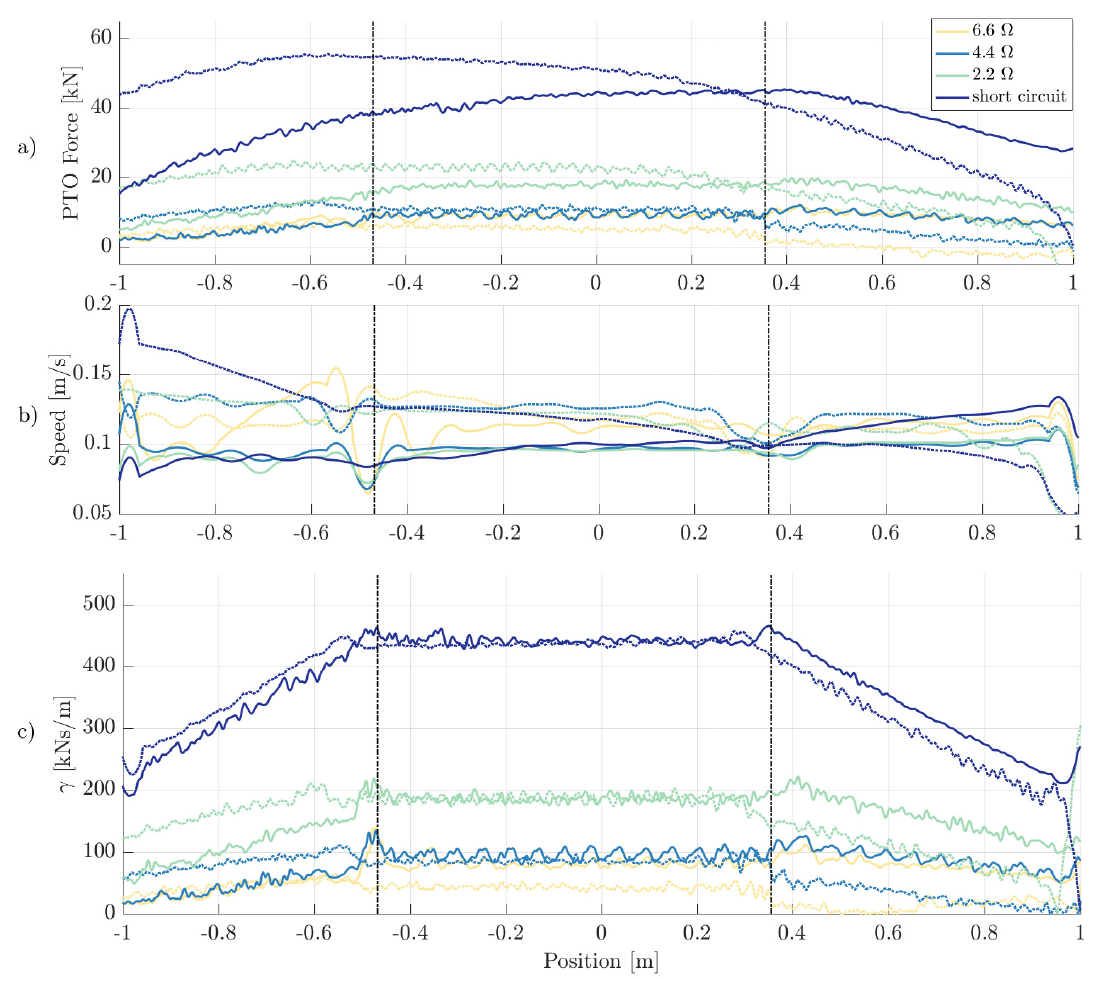
Figure 7. PTO force ( a ), translator speed ( b ) and PTO damping, γ , ( c ) for the low speed stroke. The upward motion is represented with solid lines and the downward motion is represented with dotted lines. The full active area is marked by vertical dotted